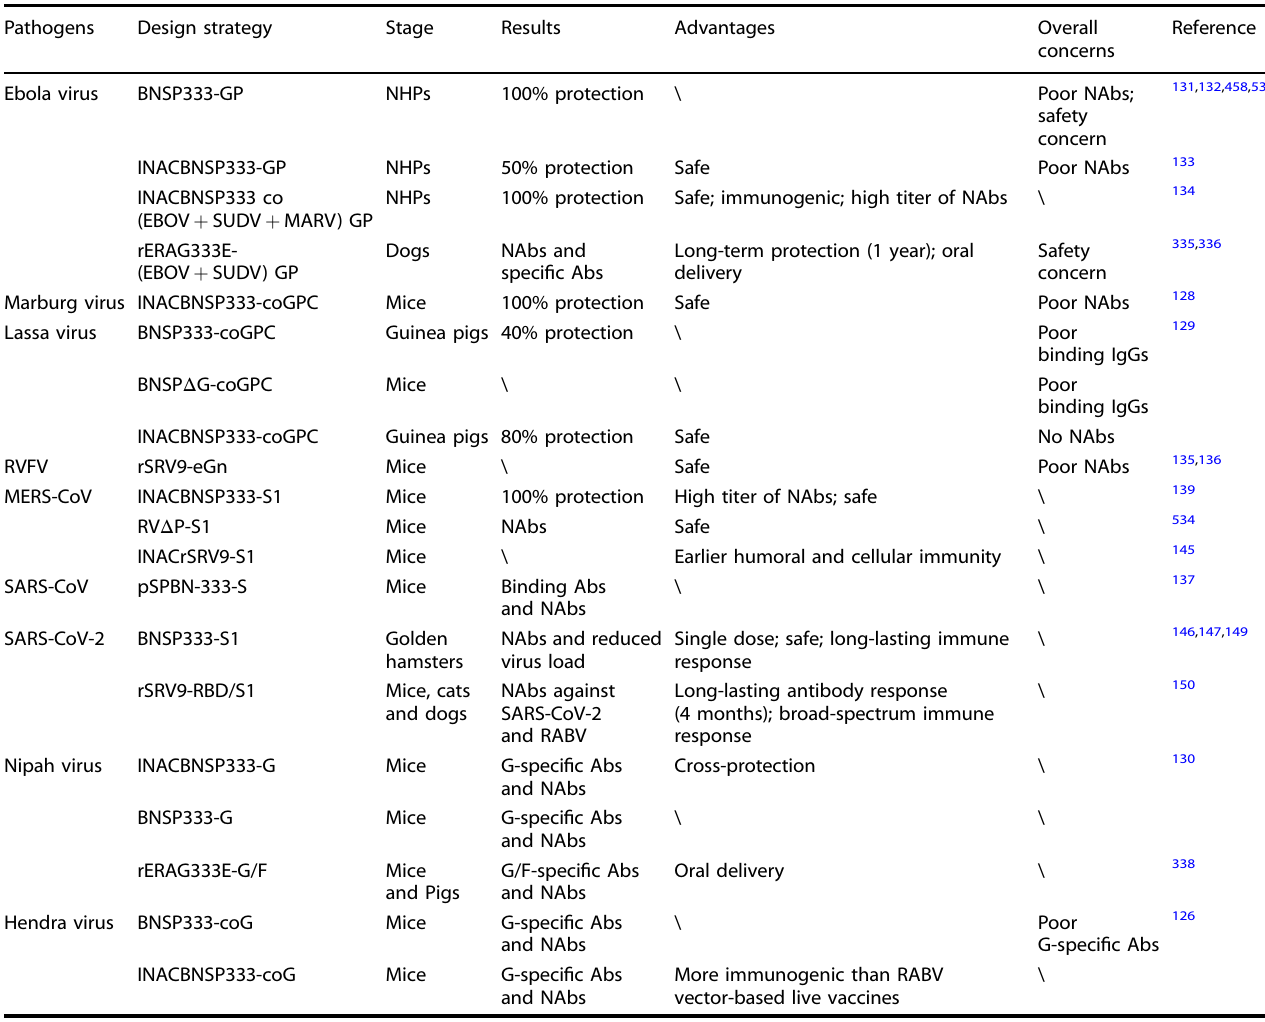
Table 3. Vaccine candidates based on rabies virus vector Pathogens Design strategy Stage